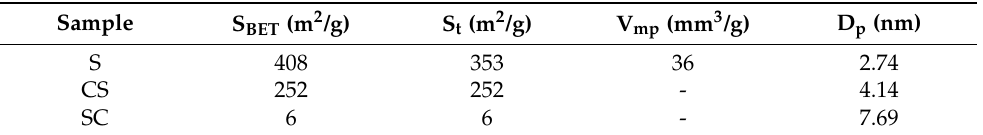
Figure 4. Nitrogen adsorption–desorption isotherms of samples S (black), SC (blue) and CS (red). Table 1. Specific surface area (S BET ), external surface (S t ), micropore volume (V mp ) and average pore diameter (D p ) of samples S, SC and